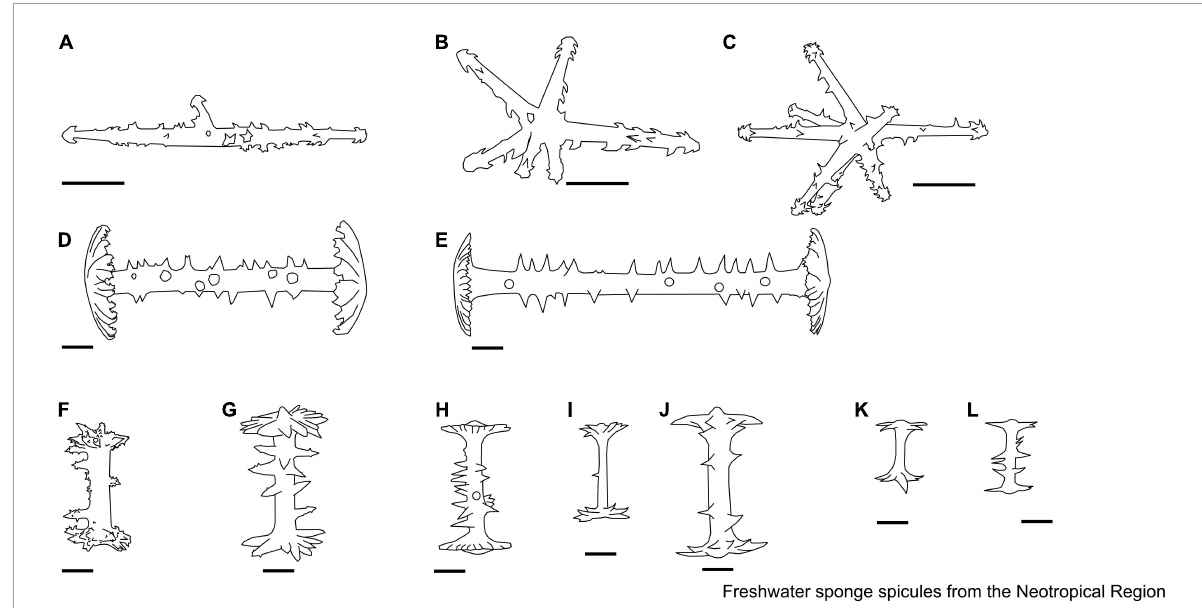
FIGURE4 (A–E) Dosilia Gray, 1867. Microscleres. (A) Aster from simple acerates with one more long divergent spined branch; (B,C) spherical aster-radiated bodies. Gemmuloscleres. (D) Birotules, spined shaft, rotules convex; (E) birotules, spined shaft, rotules of size and shape equal, flat or slightly umbonate with margins thin and numerous spines. (F–L) Ephydatia Lamouroux, 1816. Gemmuloscleres. (F) Birotules spined shaft, with secondary spines; (G) birotules with irregular rotules, shaft with long and conical spines; (H) birotules with spined shaft, flat rotules; (I–L) birotules with a smooth shaft, flat rotules, not deep irregular incisions. Scale: 10 µ m.